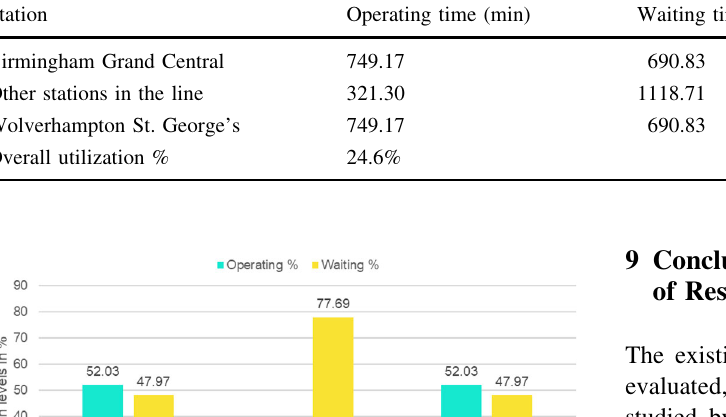
Table 13 Overall utilization levels of the metro line